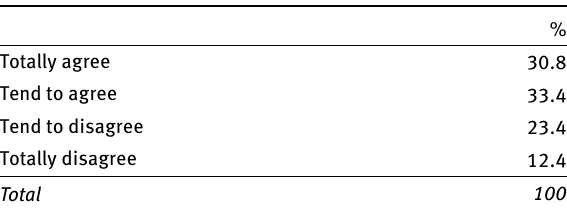
Table 5: The spread of robots will lead to human substitution at work.